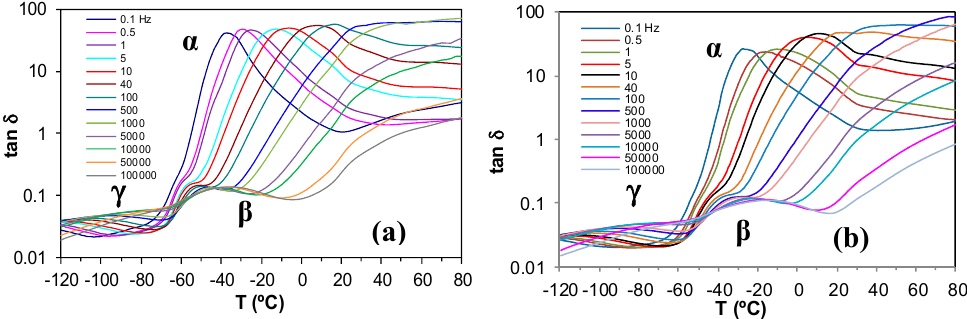
Figure 6. Dielectric relaxation curves for ( a ) PEI800 and ( b ) PEI25000. Heating rate: 0.5 °C/min.